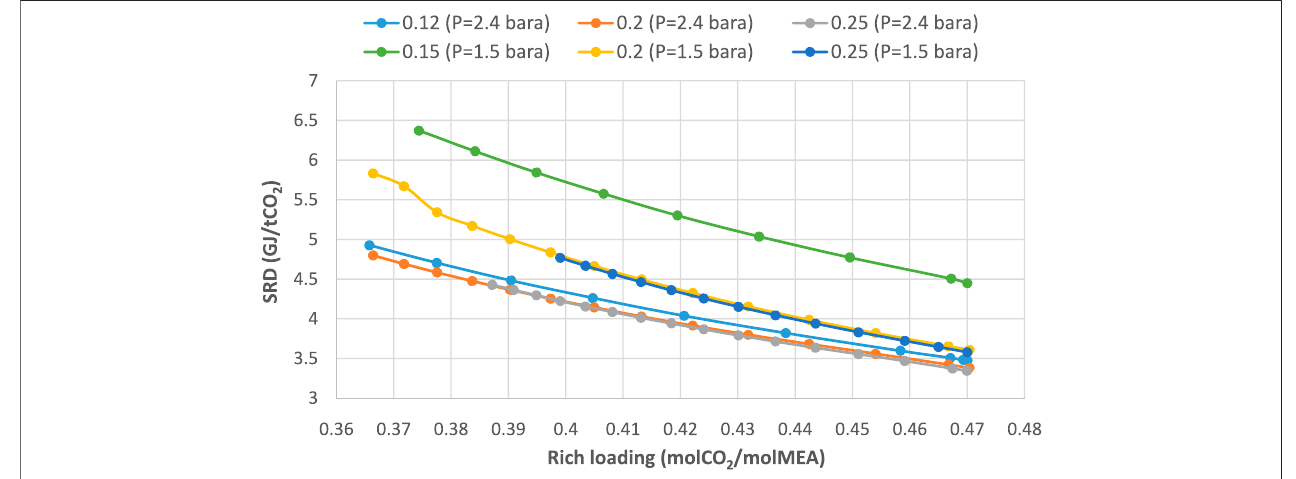
FIGURE4| Effectofrichloadingandstripperpressureonthespeci fi creboilerdutyfordifferentleanloadingsof0.12(onlyforstripperpressureof2.4bar),0.15(only for stripper pressure of 1.5 bar), 0.2, and 0.25 molCO 2 /molMEA.